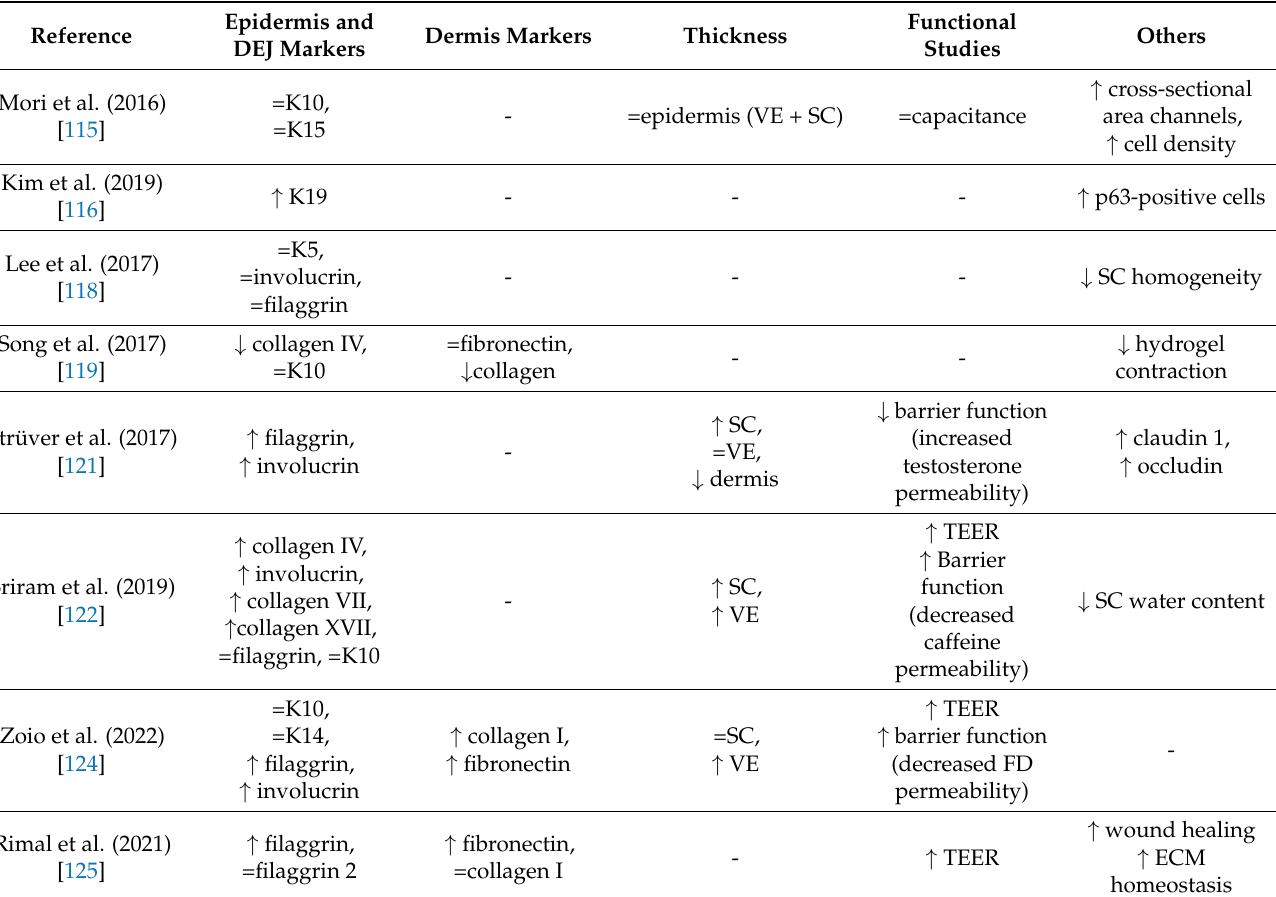
Table 4. Comparison between SoC models and static controls reported in the literature. ↑ represents increased physiological relevance of the SoC model compared to the controls, ↓ represents decreased physiological relevance of the SoC model compared to the controls, and =represents no significant difference between the SoC model and the controls. Abbreviations: DEJ, dermo-epidermal junc- tion; K, keratin; VE, viable epidermis; SC, stratum corneum; TEER, transepithelial resistance; FD, FITC-Dextran; ECM, extracellular